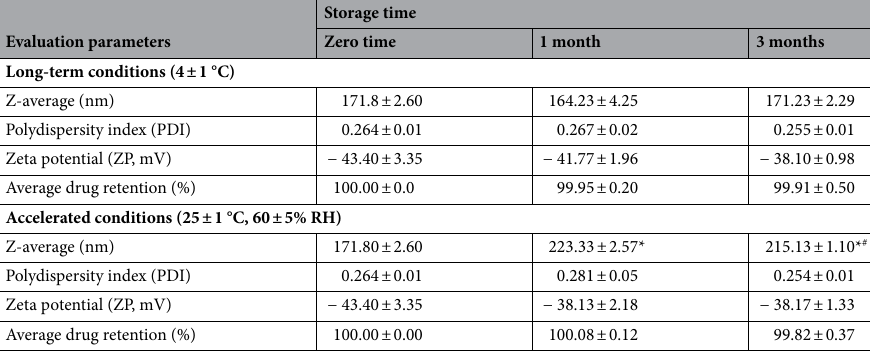
Table 1. The values of Z, PDI, ZP averages and drug retention (%) of ALAN aqueous dispersions stored at long-term storage conditions (4 ± 1 °C) and accelerated storage conditions (25 ± 1 °C, 60 ± 5% RH). Each value represents the mean ± standard deviation (SD) (n = 3). *Significant at p < 0.05 monthly vs. initial. # Significant at p < 0.05 refrigeration vs. ambient conditions after 3 months.